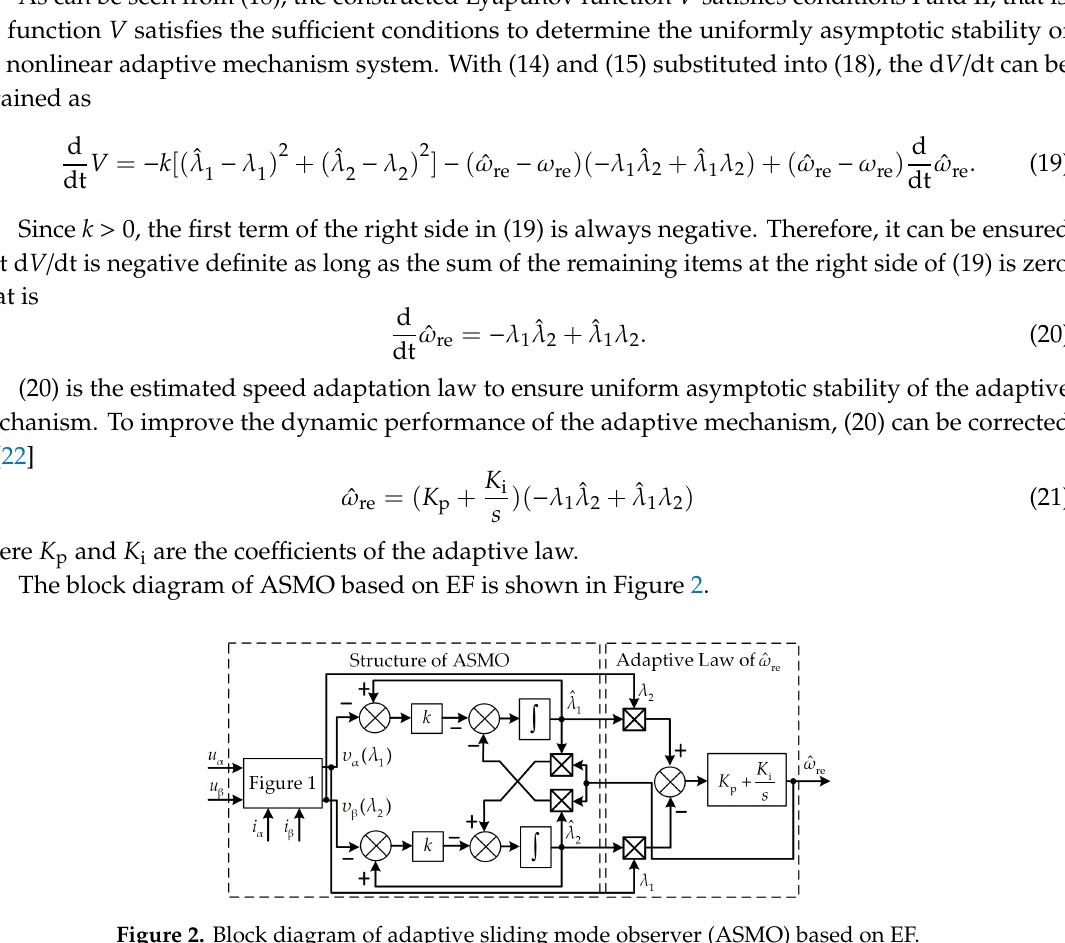
Figure 2. Block diagram of adaptive sliding mode observer (ASMO) based on EF.